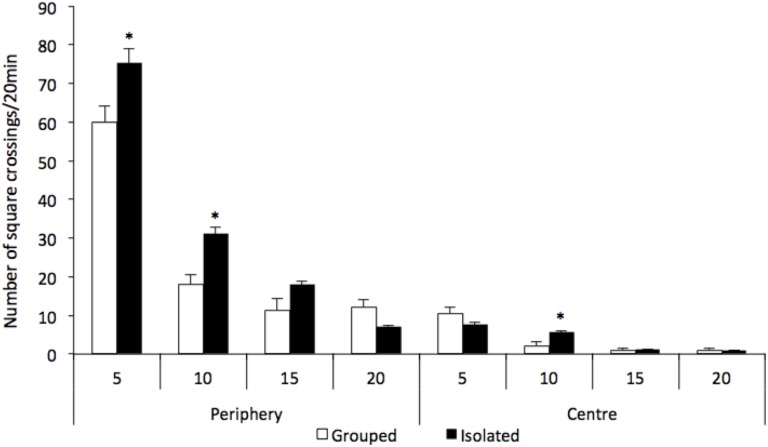
Effect of rearing condition (isolated vs. grouped) at spontaneous number of crossings at the open field (20 min). Number of crossings is represented as 5-min time bins over the 20 min of test. Repeated measures ANOVA showed a significant group and local and time interaction and post hoc analysis revealed that rats reared isolated (n = 8) presented hyperlocomotion at the periphery of the arena at 5 and 10-min time bins, and at the centre of the arena at 10-min time bin when compared to grouped rats (n = 9). Data are expressed as mean ± S.E.M. ∗p < 0.05 compared to grouped rats.